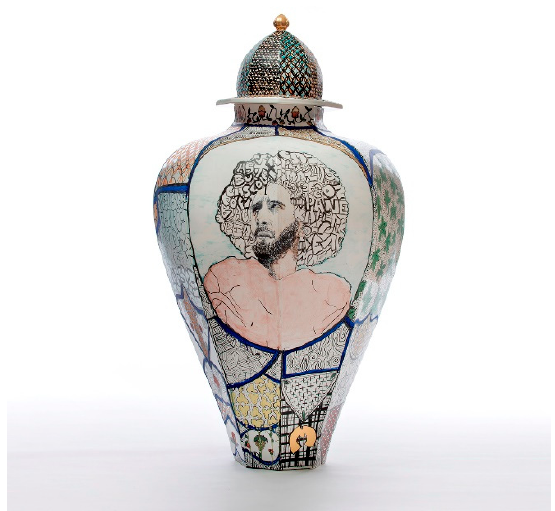
Figure 1. The Expulsion of Colin Kaepernick and John Brown, 2017 , Porcelain, china paint, luster, 47 × 24 × 24 in. Image by KeneK Photography, courtesy of Wexler Gallery.